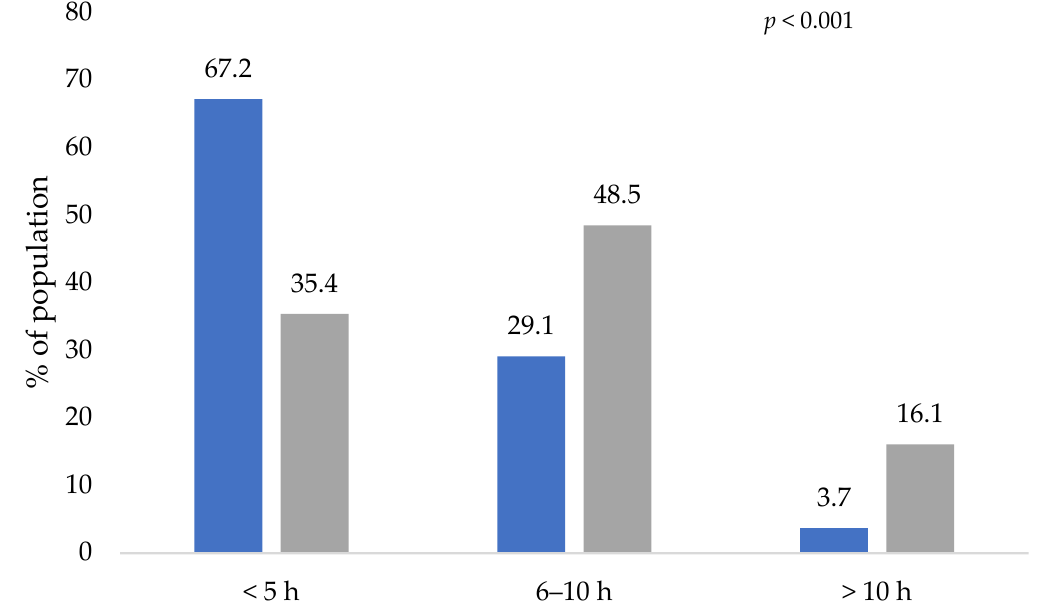
down. The p -values indicate the statistical significance of the McNemar test.